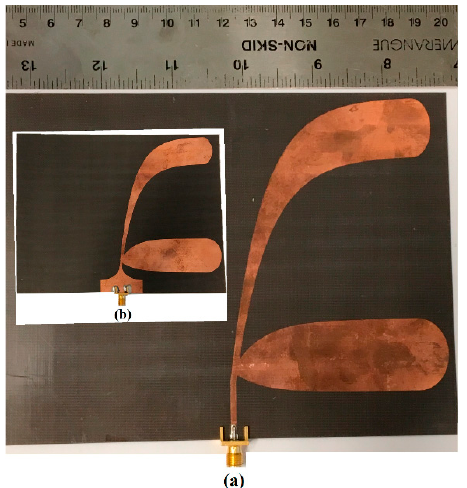
Figure 9. Photograph of fabricated antenna: ( a ) top layer and ( b ) bottom layer.